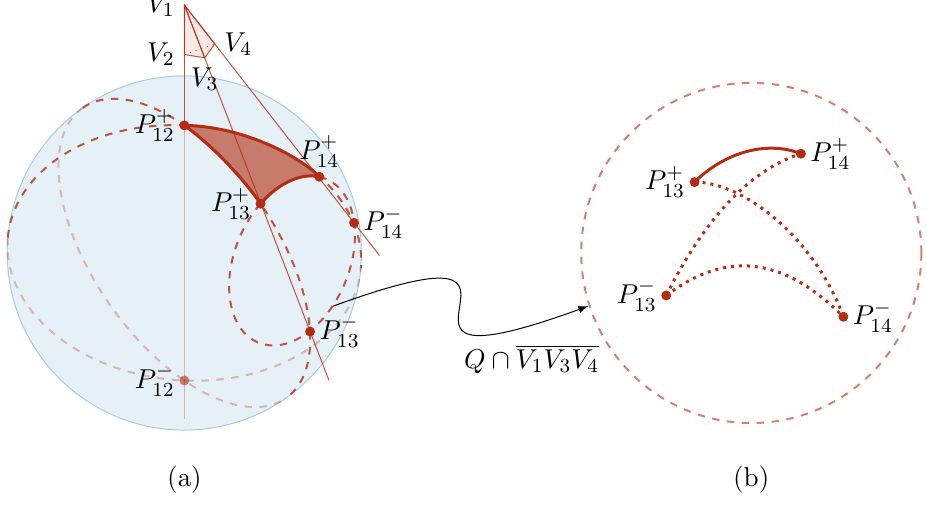
Figure 11 . The generalized simplex contour on the quadric. It is fixed up to invariant deformations once each of its 0 -face is chosen. There are in total eight different contours for the discontinuity.